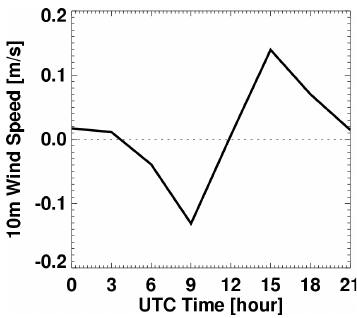
Figure 12 Dust impact on the diurnal cycle of 10m-wind averaged over the WAM region 5 (6 o N-17 o N and 15 o W-10 o E) from the WRF-Chem control simulation (i.e., ni=0.003). 6 Fig. 12. Dust impact on the diurnal cycle of 10m-wind averaged over the WAM region (6 ◦ N–17 ◦ N and 15 ◦ W–10 ◦ E) from the WRF-Chem control simulation (i.e., n i